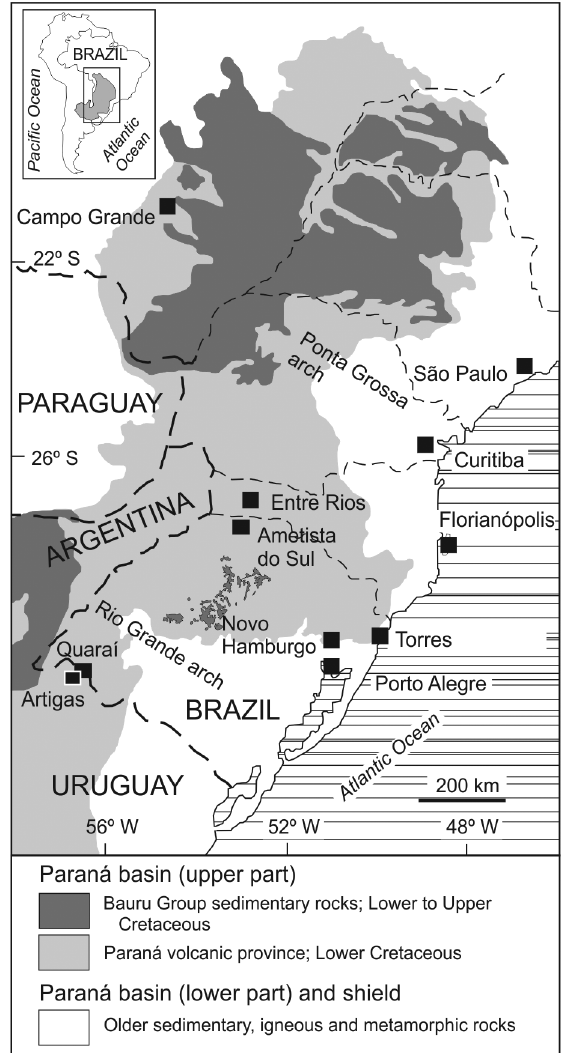
Figure 1 - Regional distribution of the Paraná volcanic province; location of Entre Rios town indicated.